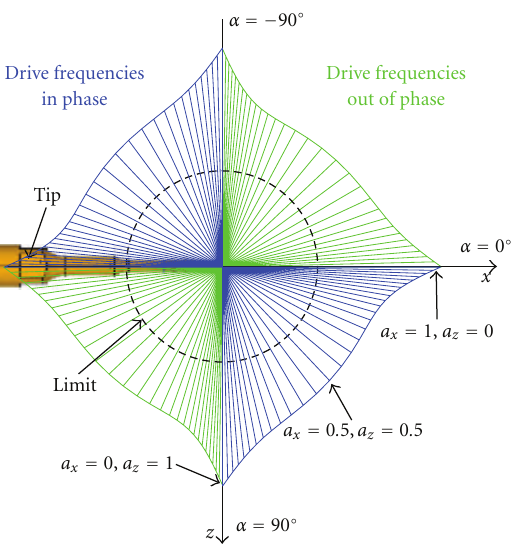
Figure 16: Plotted oscillations of the redesigned